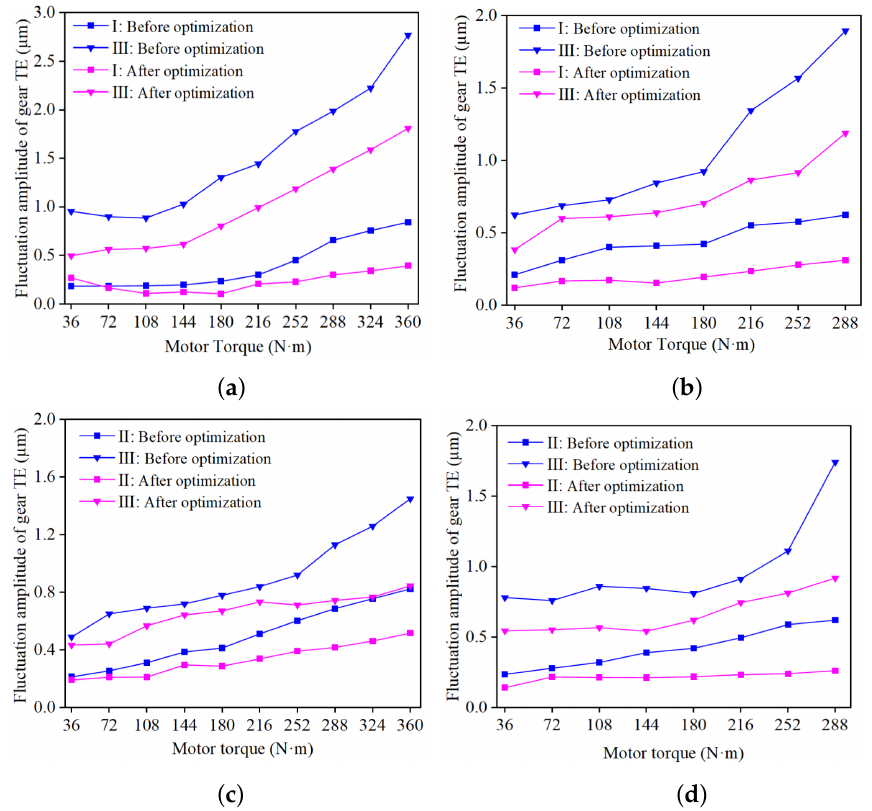
Figure 15. ( a ) Comparison of the first gear acceleration conditions before and after optimization. ( b ) Comparison of the first gear coasting conditions before and after optimization. ( c ) Comparison of the second gear acceleration conditions before and after optimization. ( d ) Comparison of the second gear coasting conditions before and after